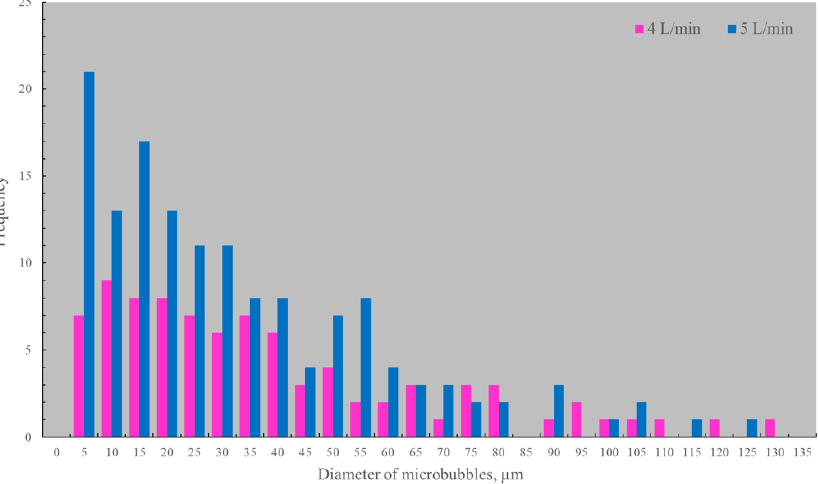
Coatings 2022 , 12 , x FOR PEER REVIEW